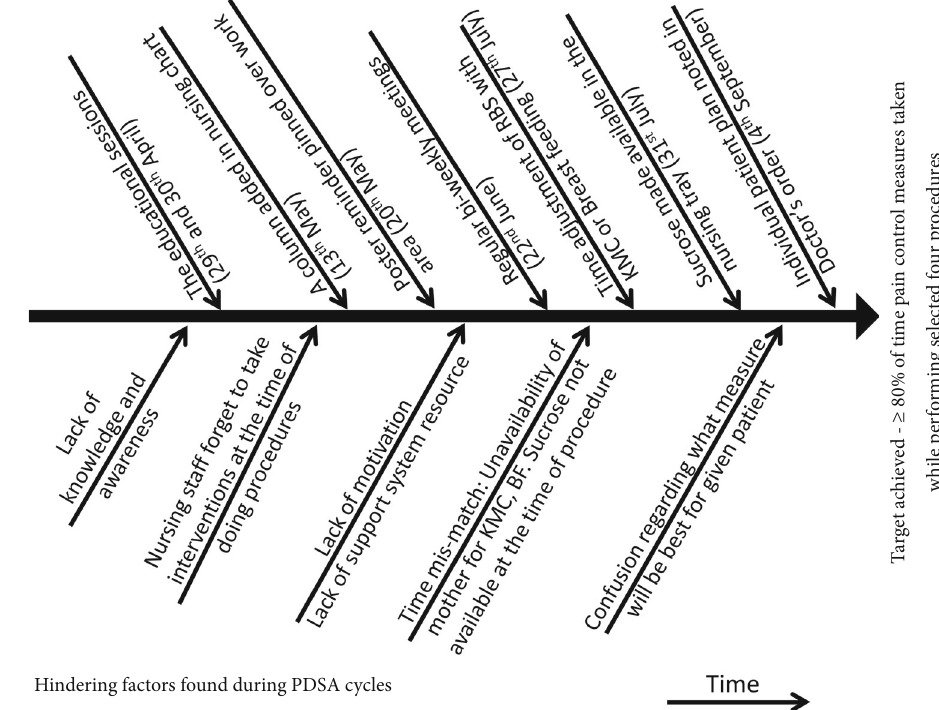
Figure 1: Diagram showing the interventions for hindering factors over